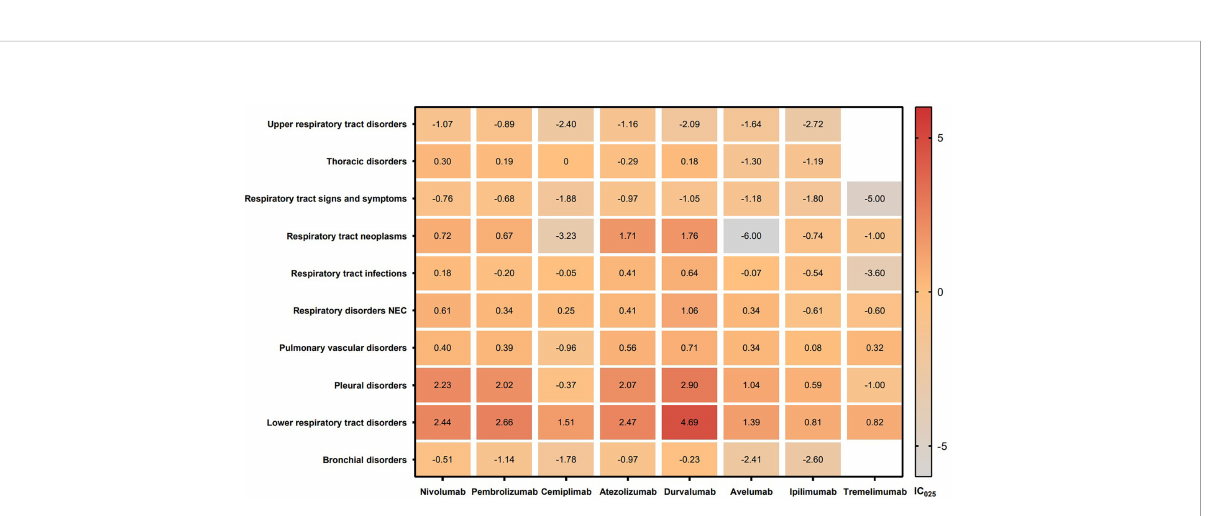
FIGURE 4 IC 025 values across class-speci fi c respiratory system toxicities and different ICI subpopulations. ICIs, immune checkpoint inhibitors; IC, information